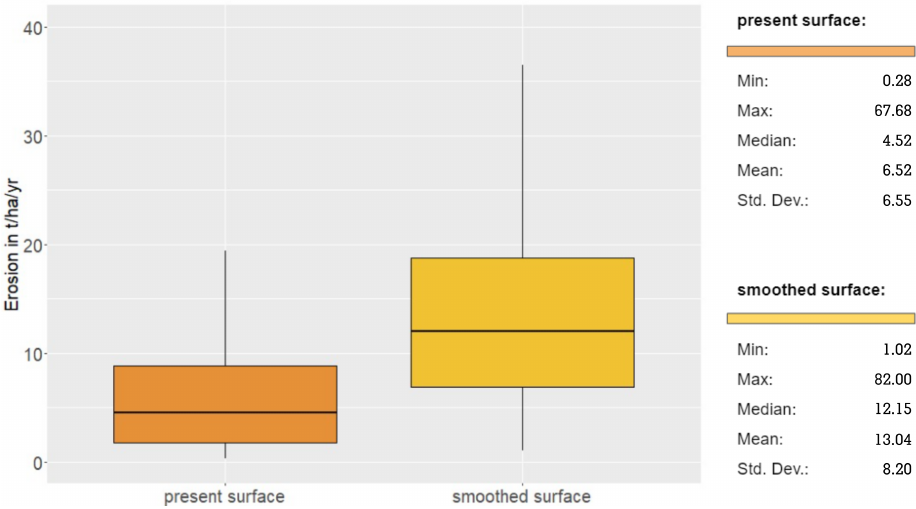
Figure 5. Boxplot and summary statistics of raster cell values of both erosion model